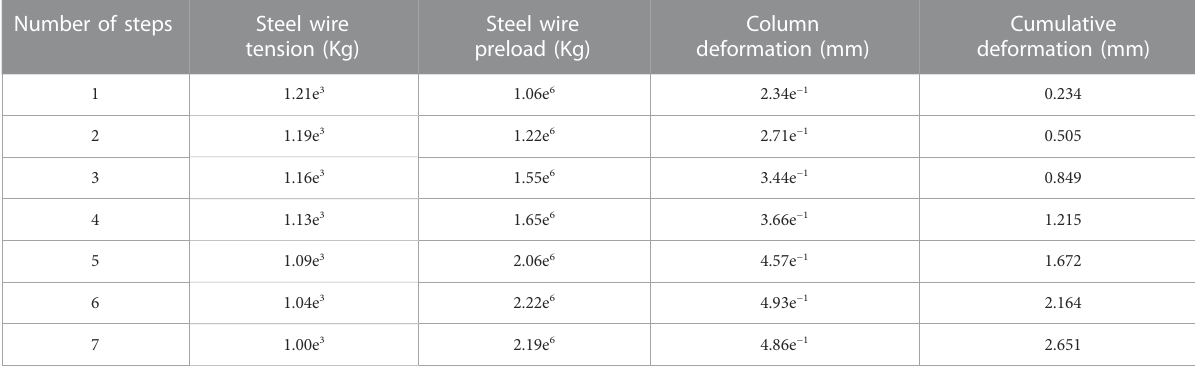
TABLE 2 Vertical deformation of HPC. Number of steps Steel wire tension